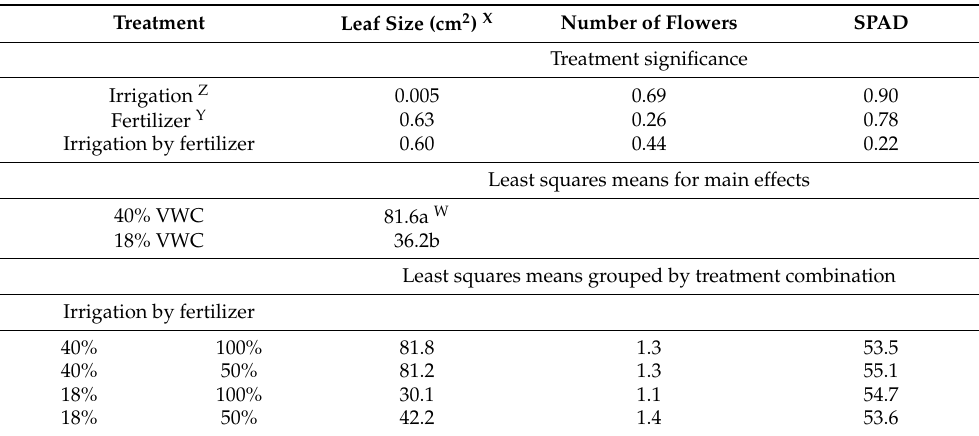
Table 3. Leaf size, number of flowers, and leaf greenness [Special Products Analysis Division (SPAD] of ‘Visions’ astilbe at the conclusion of the 61 d experiment. The 40% VWC treatment was considered well-watered while the 18% treatment supplied a reduced irrigation treatment. Leaf size of ten fully expanded leaves was measured at the conclusion of the experiment using a leaf area